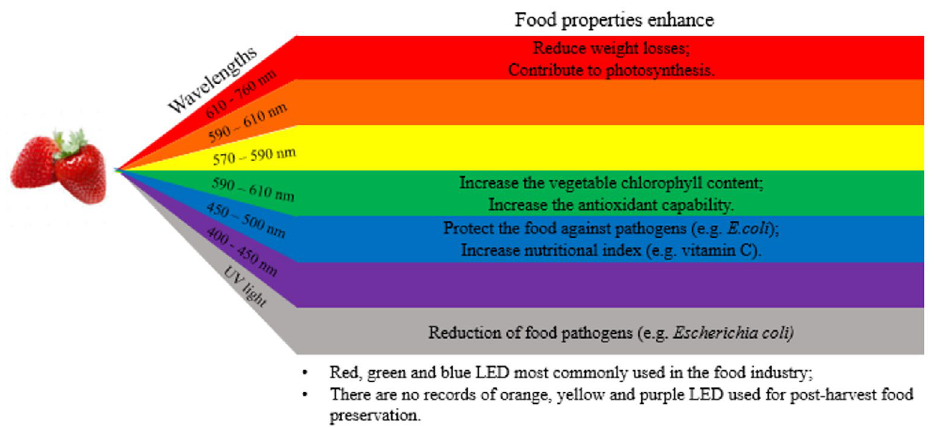
Fig 1. LED and UV-LED wavelengths and applications over food